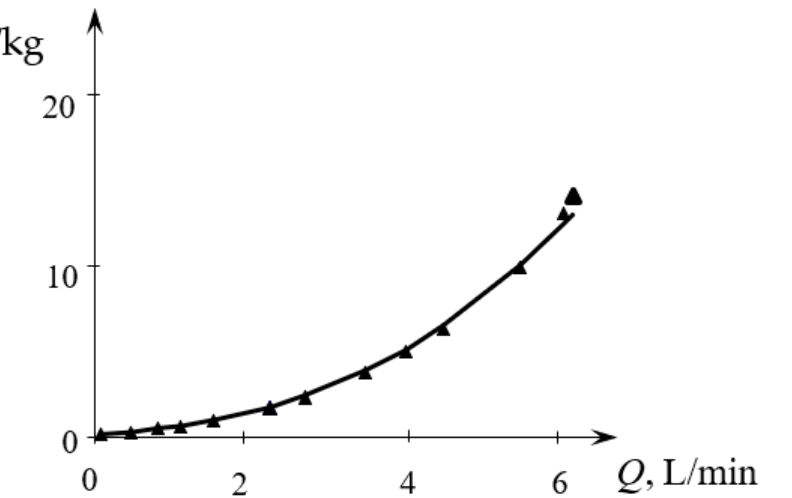
2 846 0 074 . . Q   ( Q is in L/min, ε is in